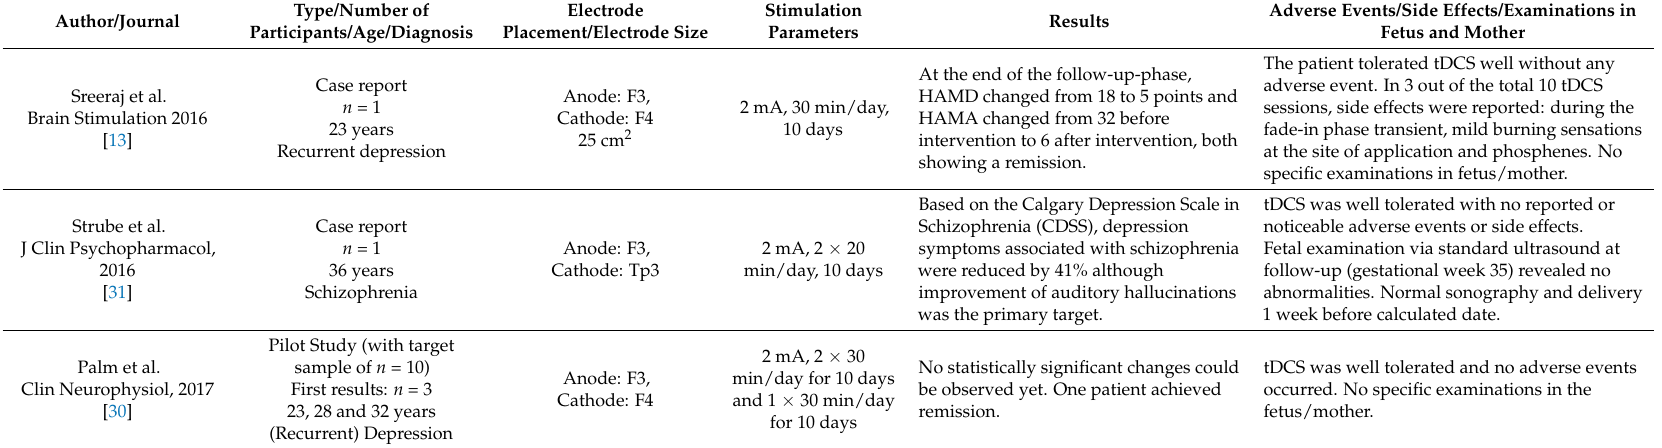
Table 2. Characteristics of studies and case reports on transcranial direct current stimulation (tDCS) use in